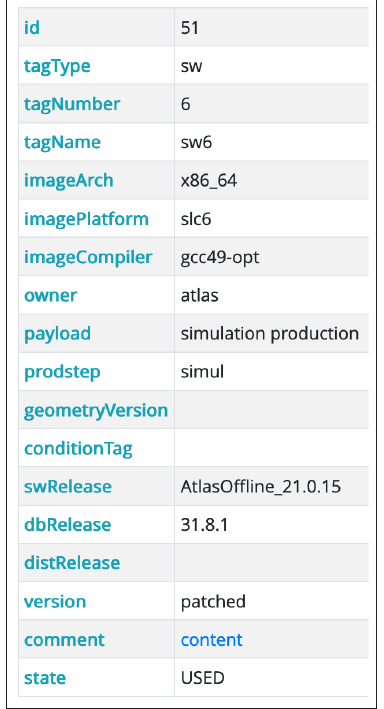
Figure 2. The content of a software stack identifier (sw6-tag) in